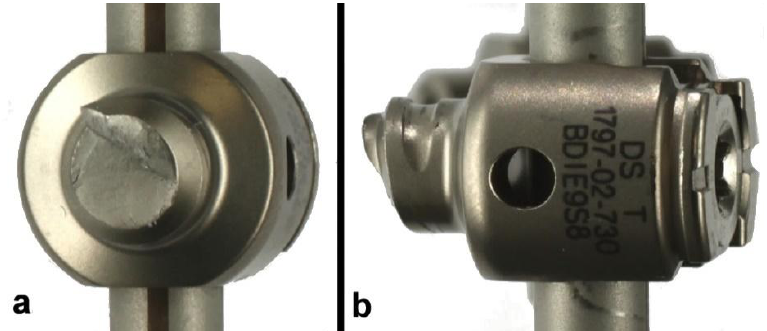
Figure 7. Sites of the titanium screw fracture of CoCr control group (CoCr-CG) post biomechanical testing.